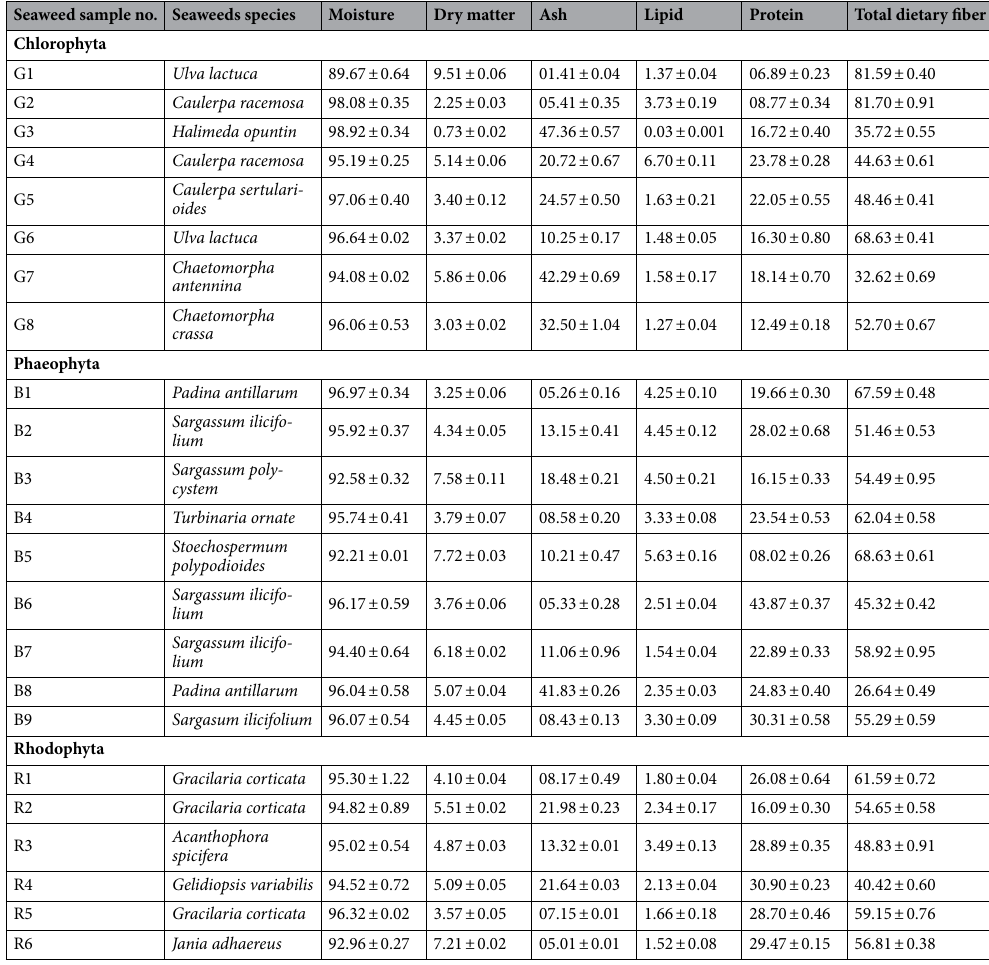
Table 2. Proximate composition values and the respective seaweed species (mean ± SE).